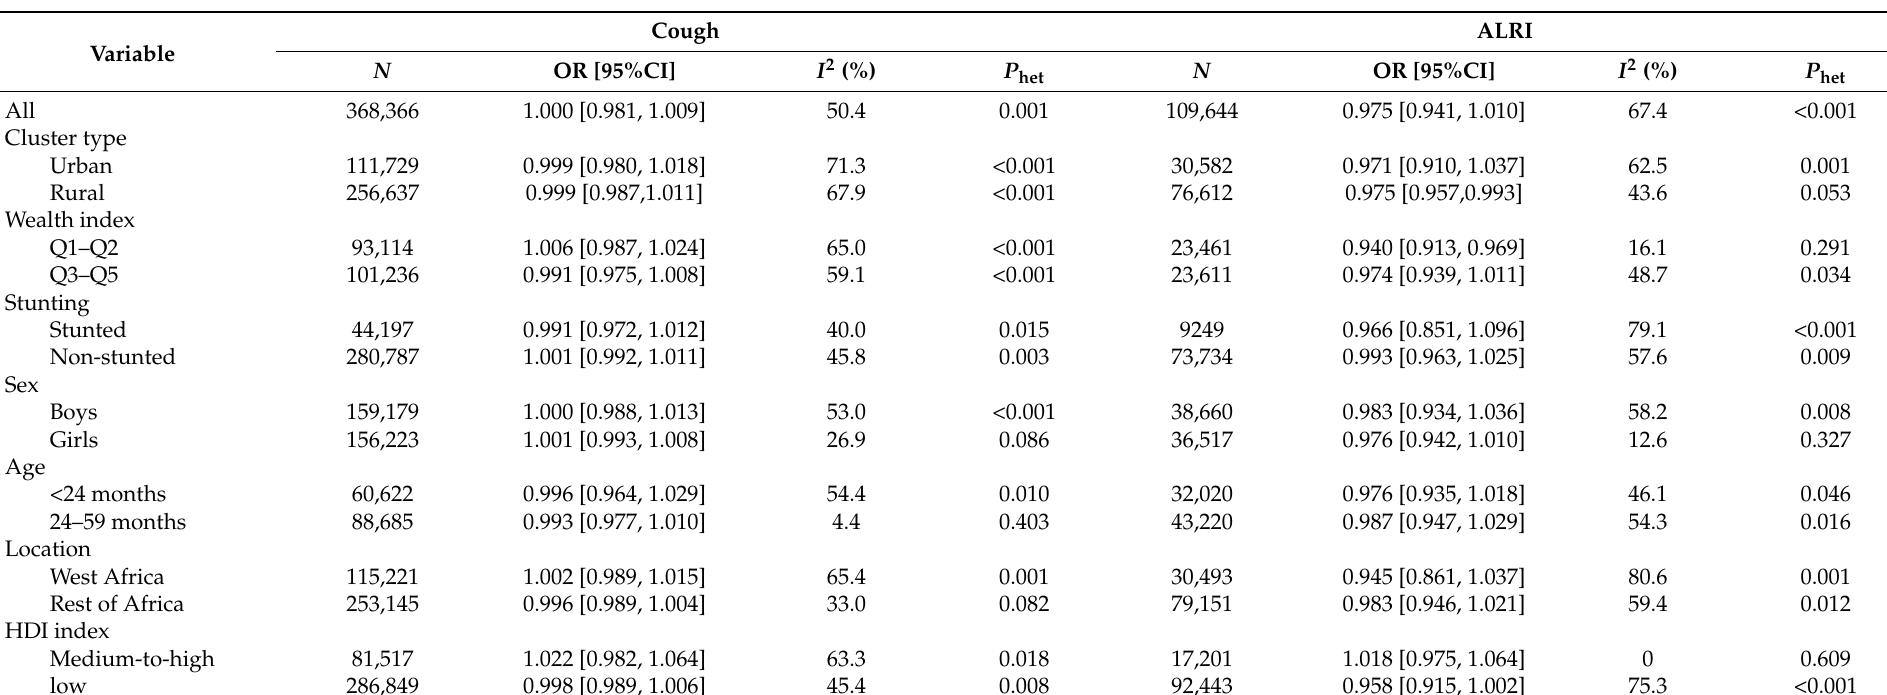
Table 3. Associations between prior-month PM 2.5 exposure (per 1 µ g/m 3 higher) and prevalence of cough or ALRI in the past two weeks across Demographic and Health Surveys (DHS) in sub-Saharan